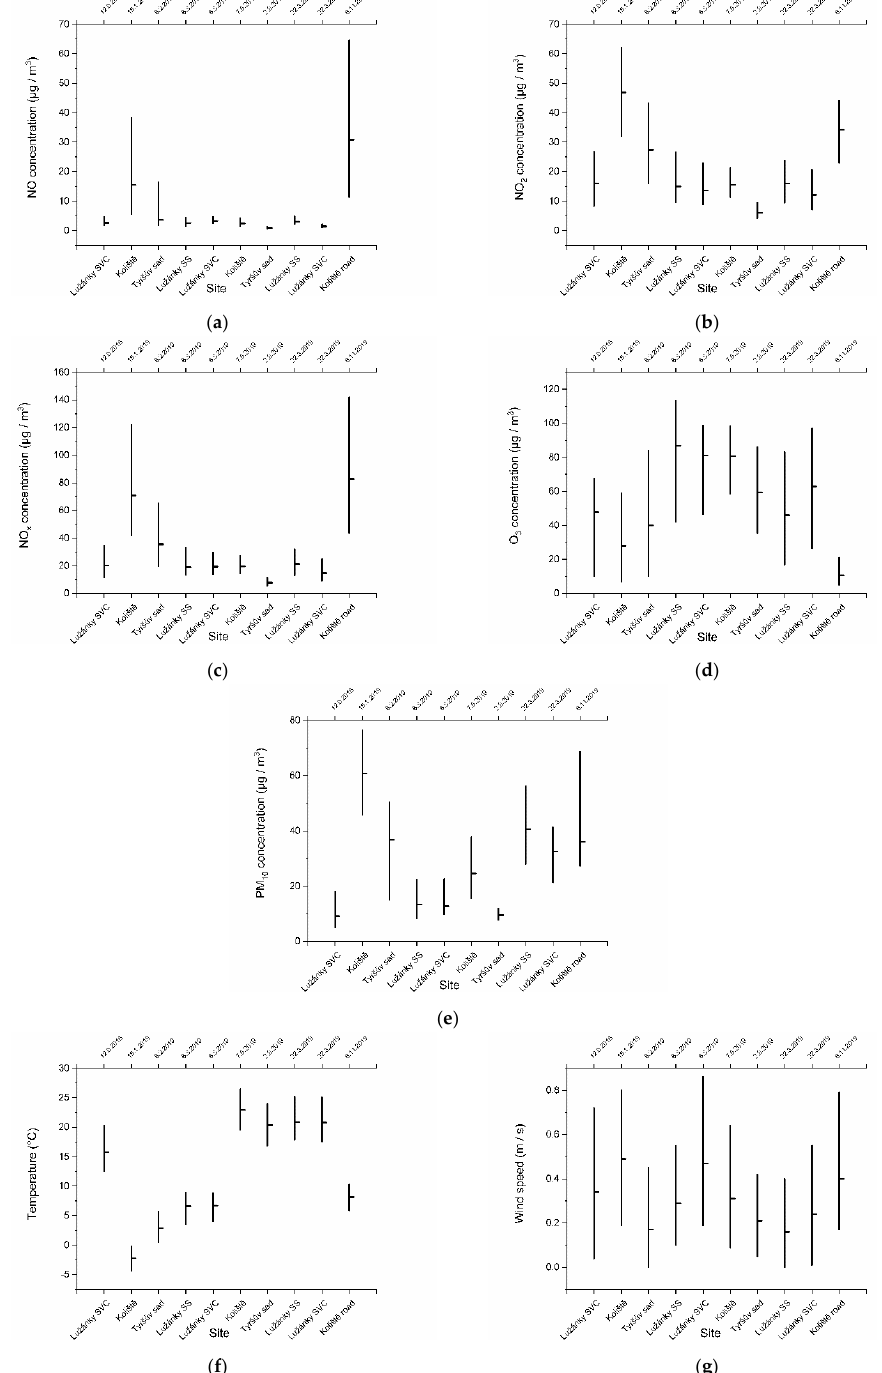
Figure 6. The NO ( a ), NO 2 ( b ), NO x ( c ), O 3 ( d ), and PM 10 ( e ) concentrations and temperature ( f ) plus wind speed ( g ) measured in the parks: the medians and quartiles.